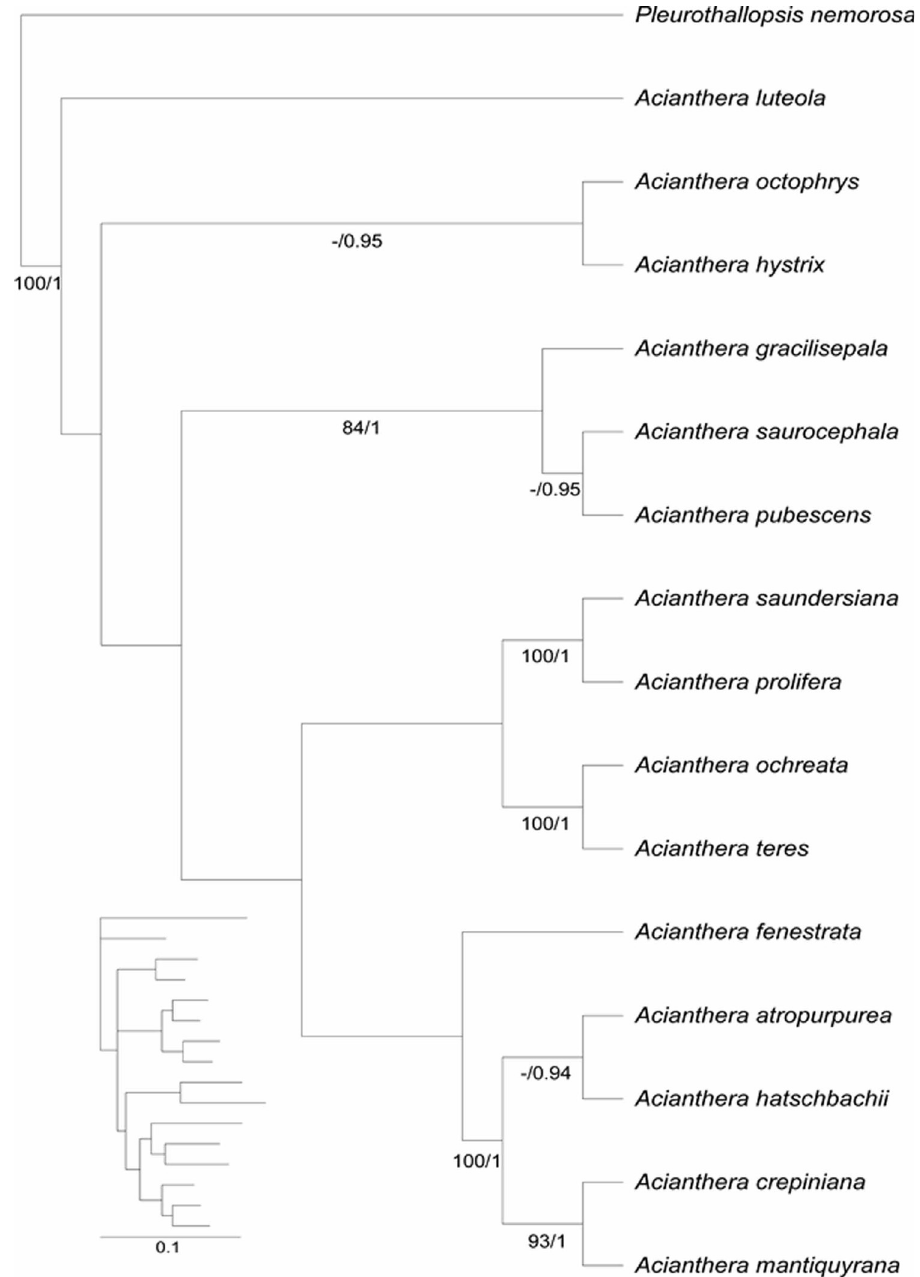
Fig 6. Strict consensus tree from maximum parsimony analysis. Analysis based on molecular data from cpmatK and nrITS, anatomical data for vegetative organs and floral micromorphology data. Bootstrap support and posterior probability values above 50 are indicated on the branches. Inset: majority consensus tree from Bayesian inference analysis showing proportional branch